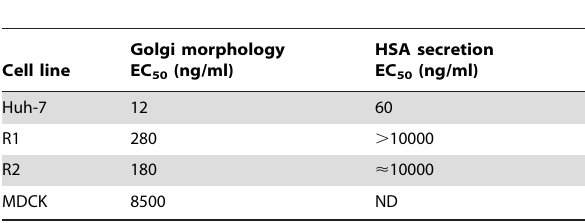
Table 3. Half maximal effective concentrations of BFA effects on the cis-Golgi morphology and HSA